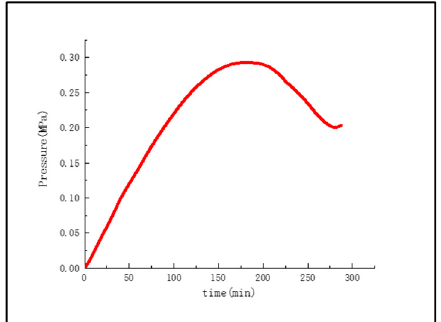
Figure 7. Dynamic dissolution curve of the core.